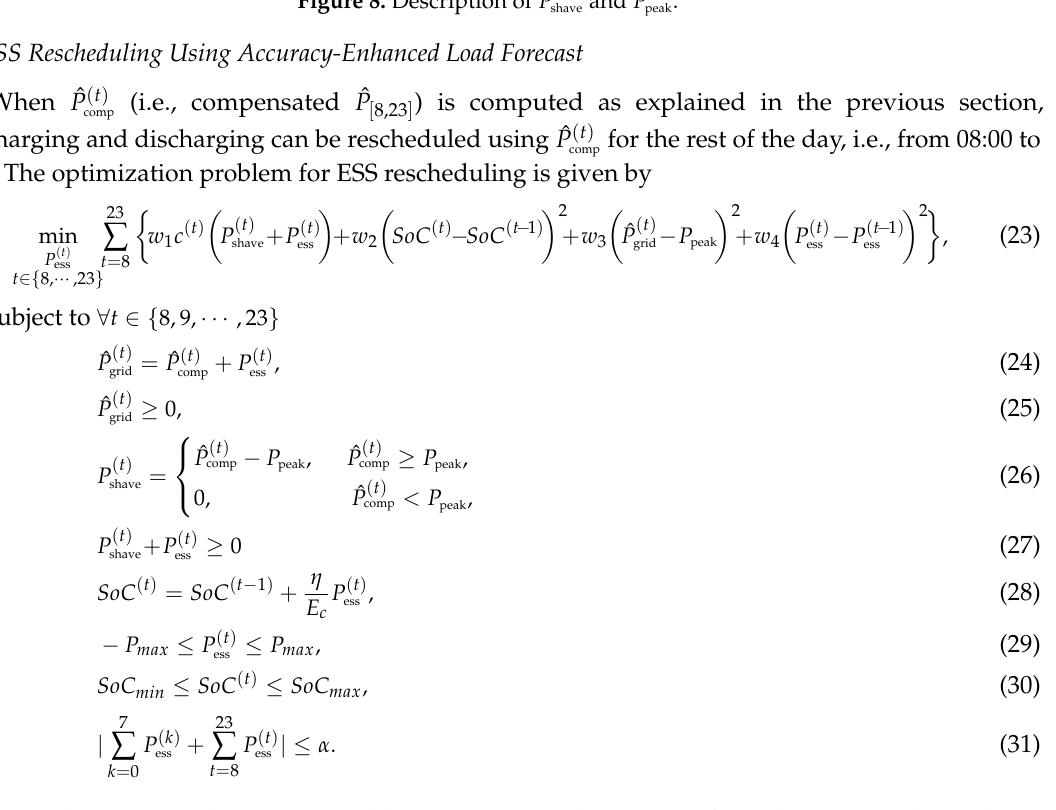
Figure 8. Description of P